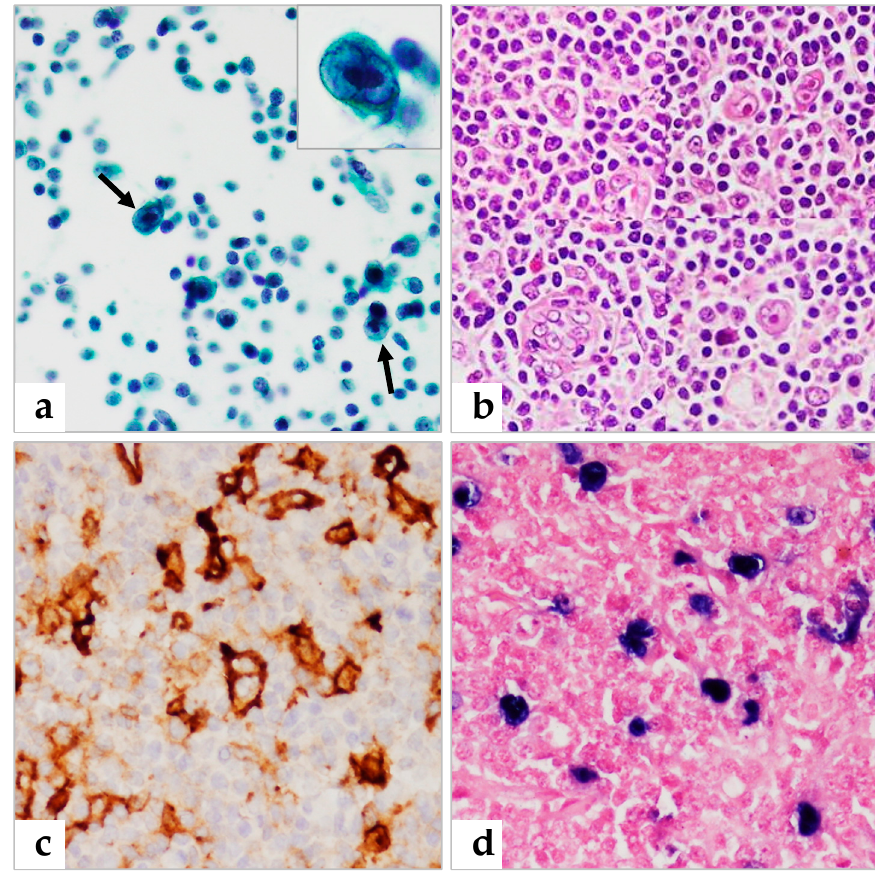
Figure 4. Classical Hodgkin lymphoma. ( a ) Pap smear showing atypical cells (arrows) at lower magni-